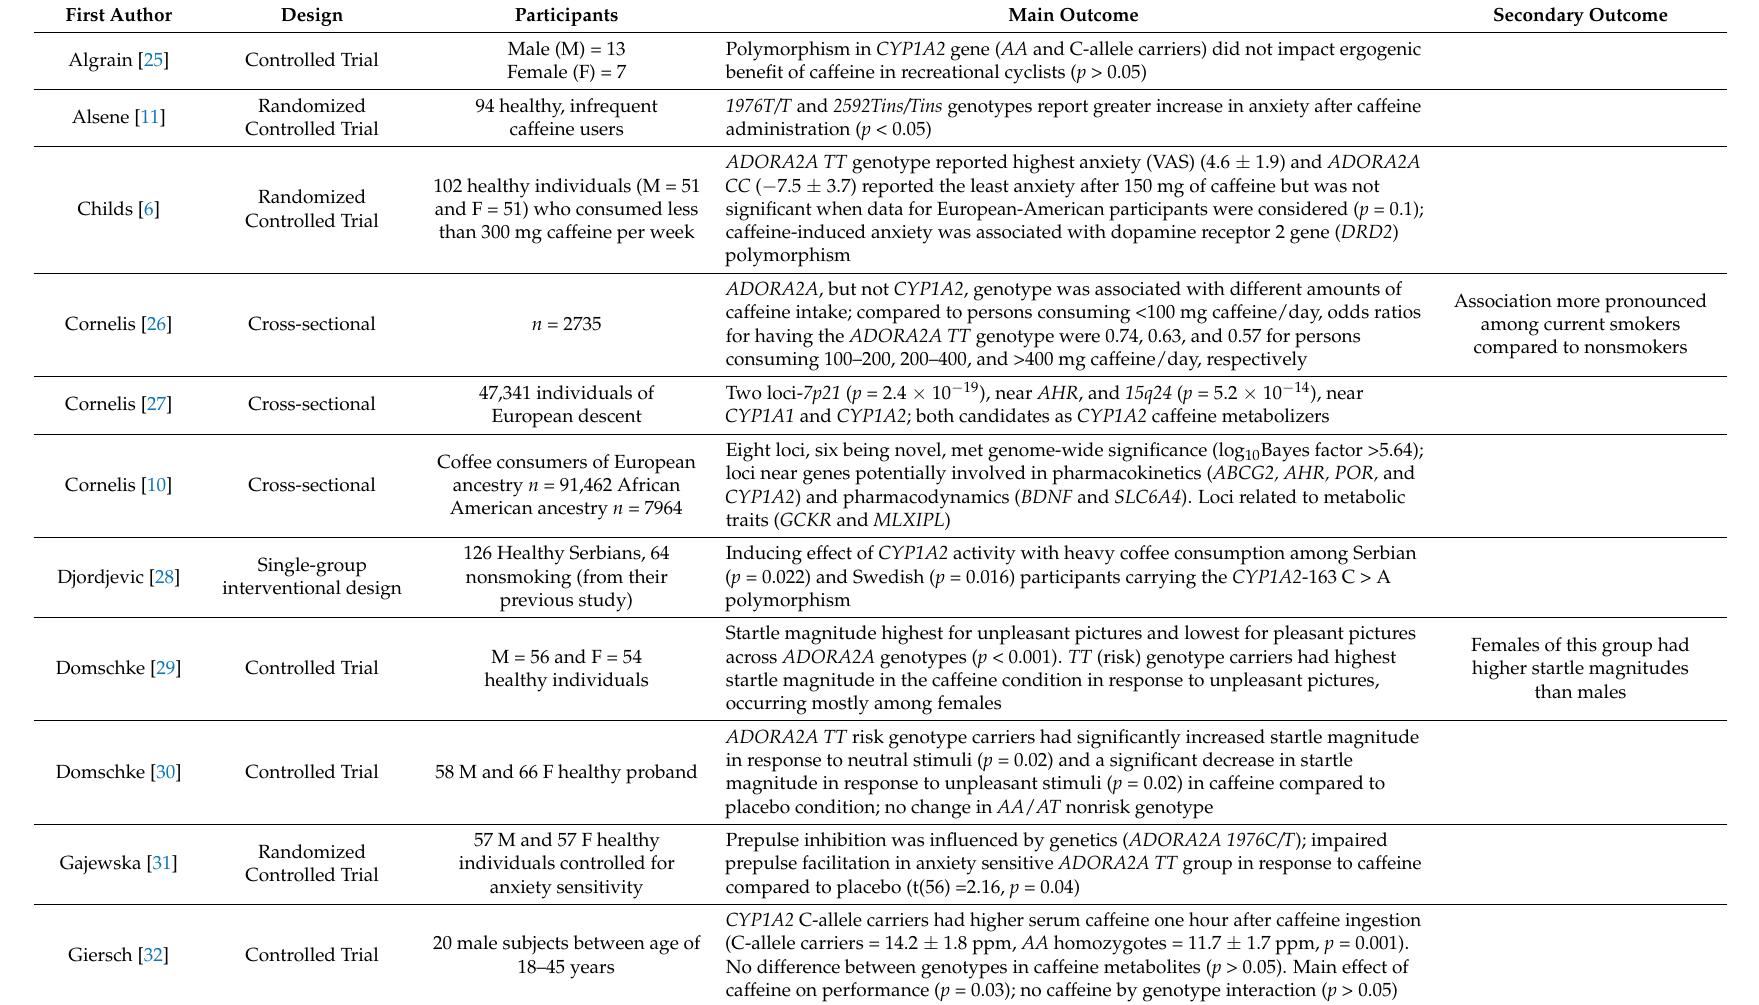
Table 1. Characteristics of the studies included in the systematic